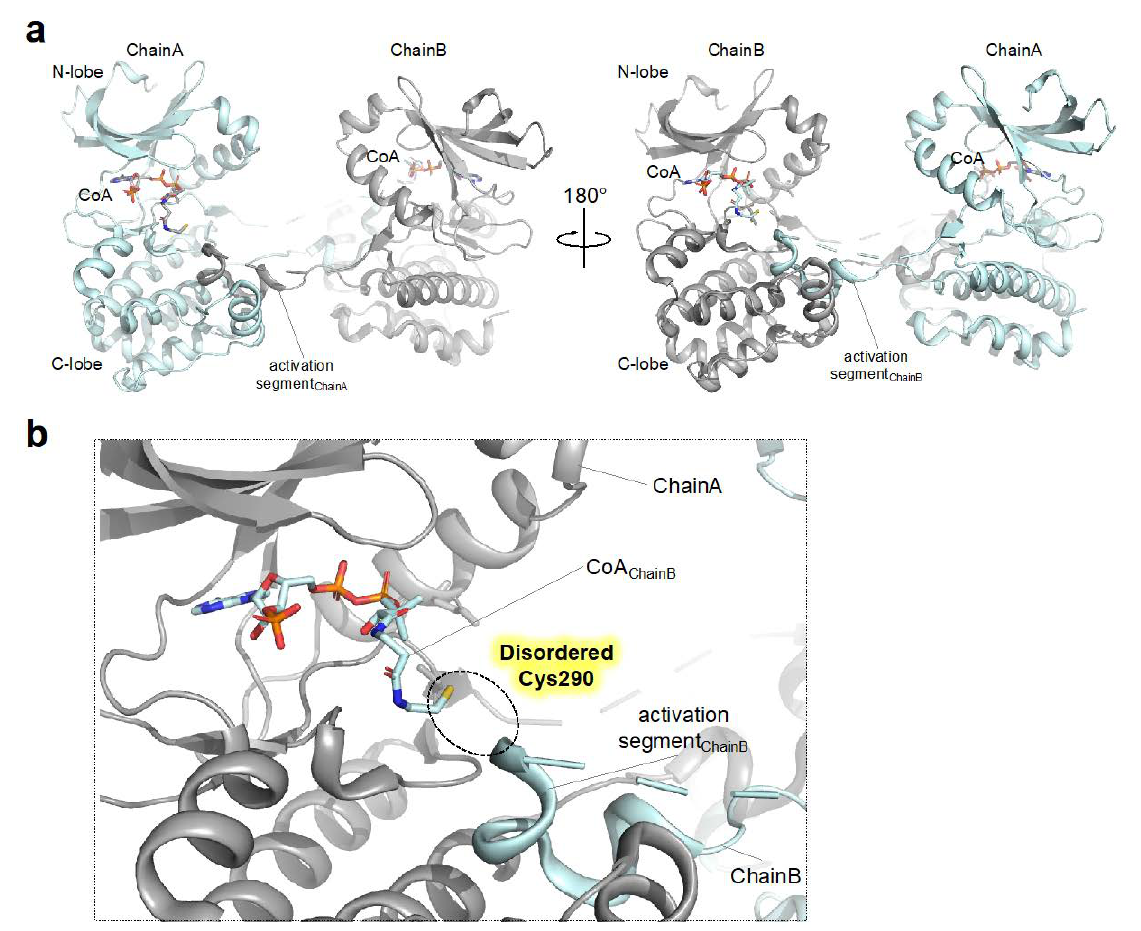
Figure 3. Structure of dimeric CoAlated AURKA structure ( a ) Crystal structure (shown as ribbon representation) of AURKA bound to CoA (PDB ID: 6XKA) displaying dimeric structure. ( b ) Close-up view of the active site (ATP binding pocket) of CoAlated AURKA. As the structure contains only one molecule in the asymmetric unit, Chain B denotes the AURKA molecule present in the neighboring asymmetric unit, not in the same unit. Also, the portion of the activation segment containing Cys290 is disordered and therefore not modeled in the